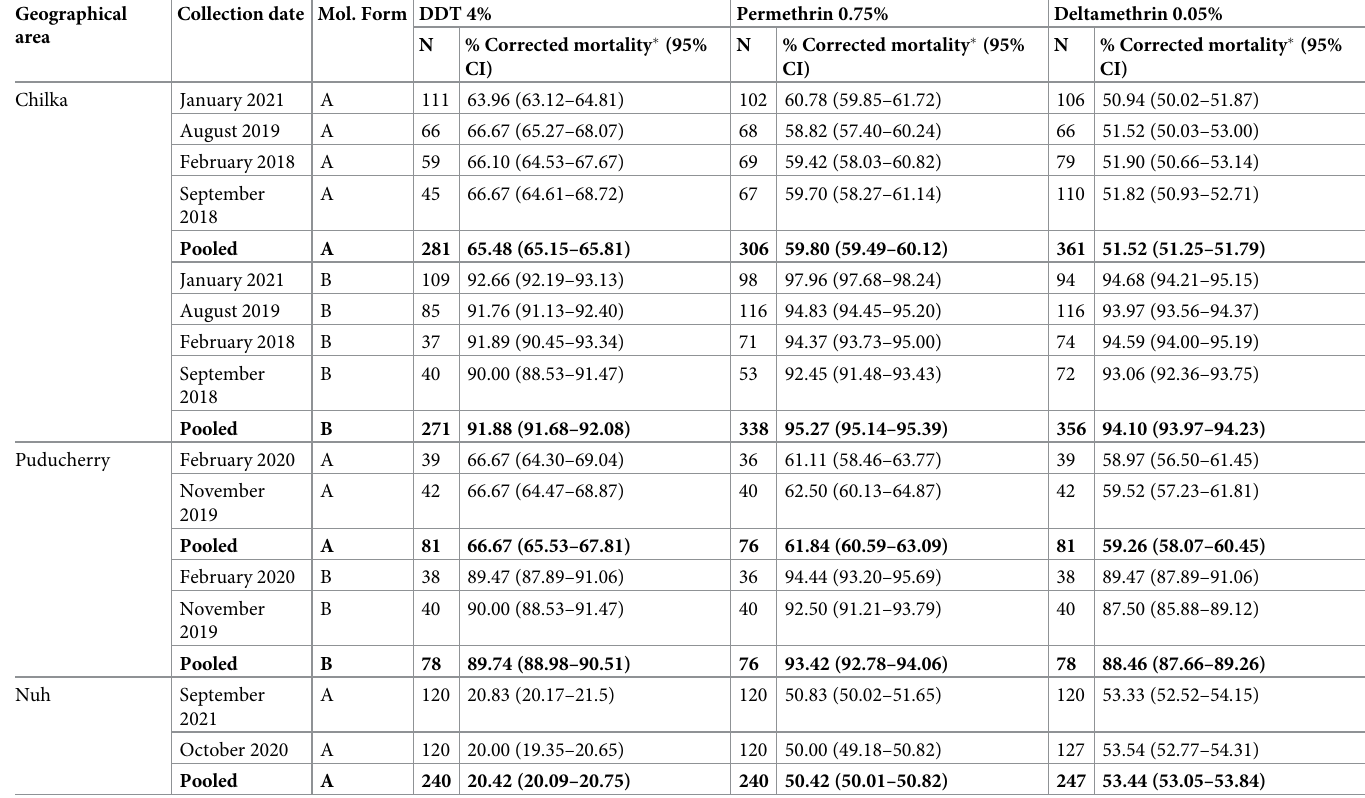
Table 2. Results of adult insecticide susceptibility tests carried out on two molecular forms of An . subpictus . Geographical